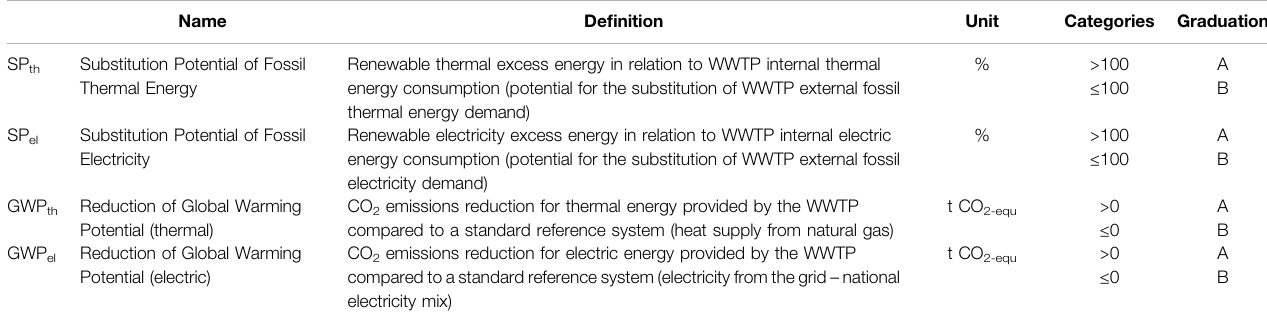
TABLE 3 | Criteria for the environmental pre-assessment (own